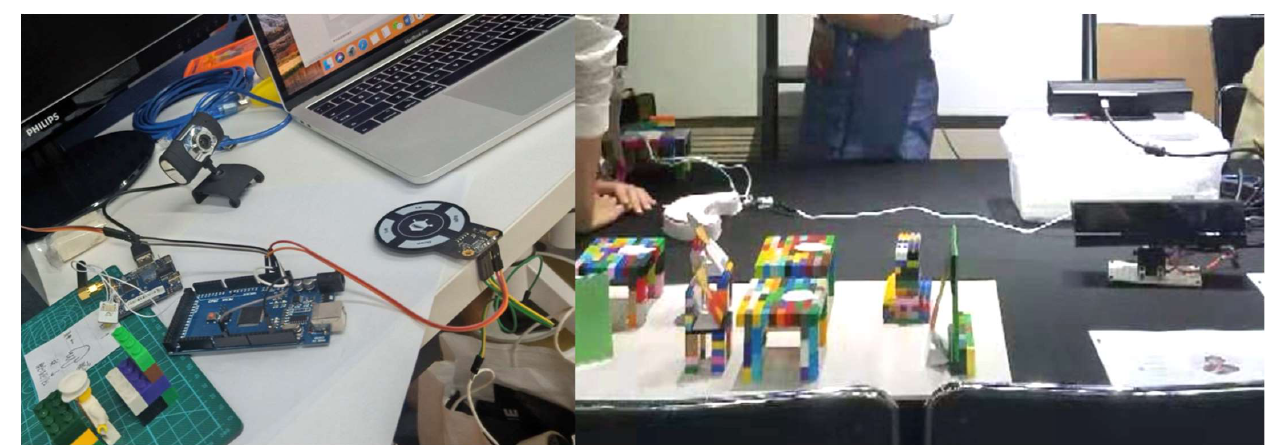
Figure 3. The Figure 3. The prototype.